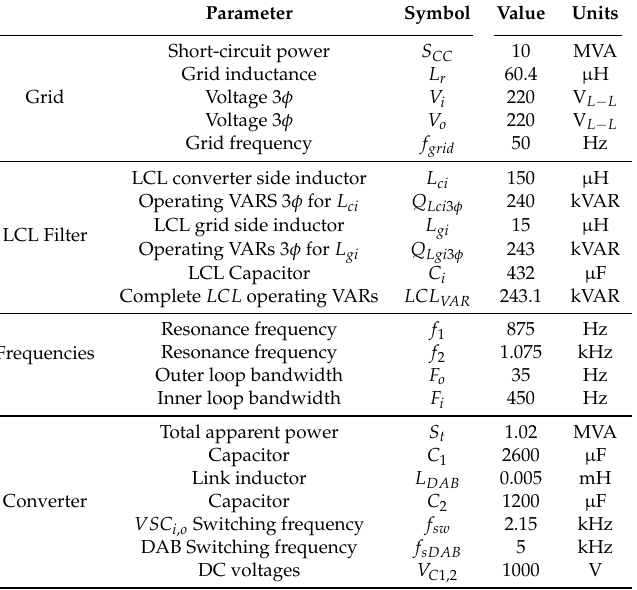
Figure 2. Control scheme. Table 1. Simulation